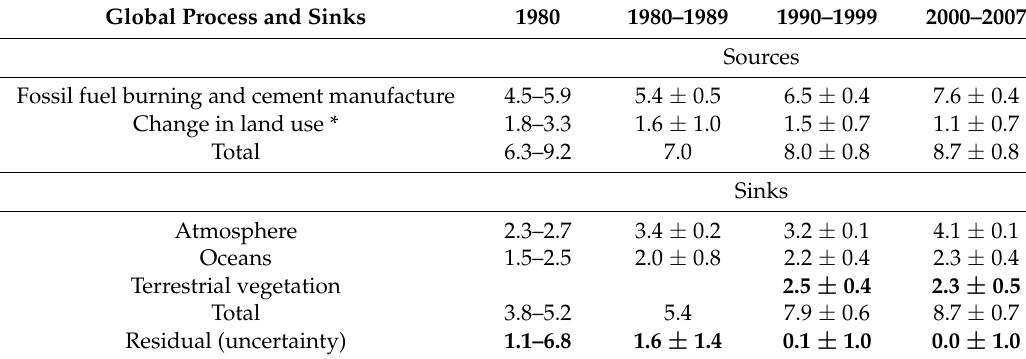
Table 1. Consensus on the magnitude of atmospheric global carbon source and sink fluxes (Pg/year) at four historic moments. The perceived role of vegetation as a carbon sink and the level of uncertainty in the budget estimate are highlighted (rows in bold). Values are based on [55–57].